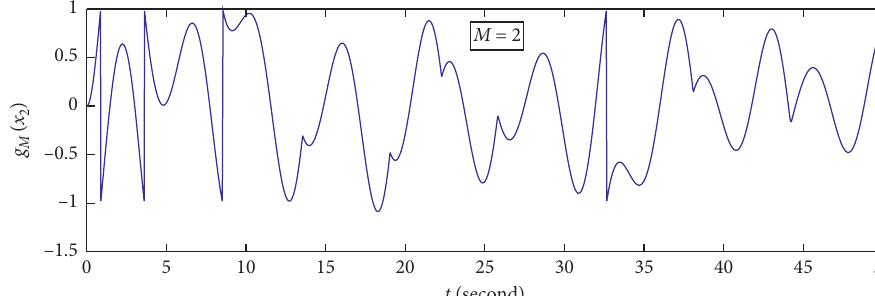
Figure 2: The function curve of g